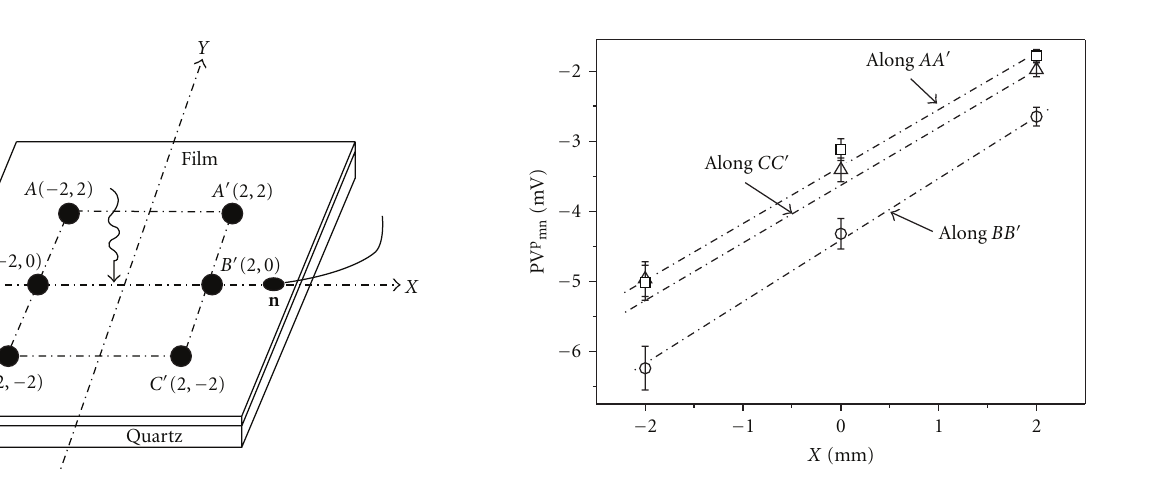
smooth, basically silver nanocluster uniformly distributed in the film.